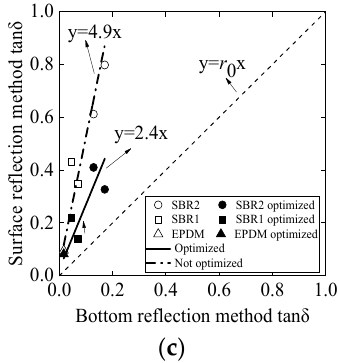
Figure 10. Linear approximation of the SRM and BRM experimental results for different kinds of rubber materials: ( a ) analysis of storage modulus L (cid:4593) results; ( b ) analysis of loss modulus L (cid:4593)(cid:4593) results; ( c ) analysis of loss tangent tan δ